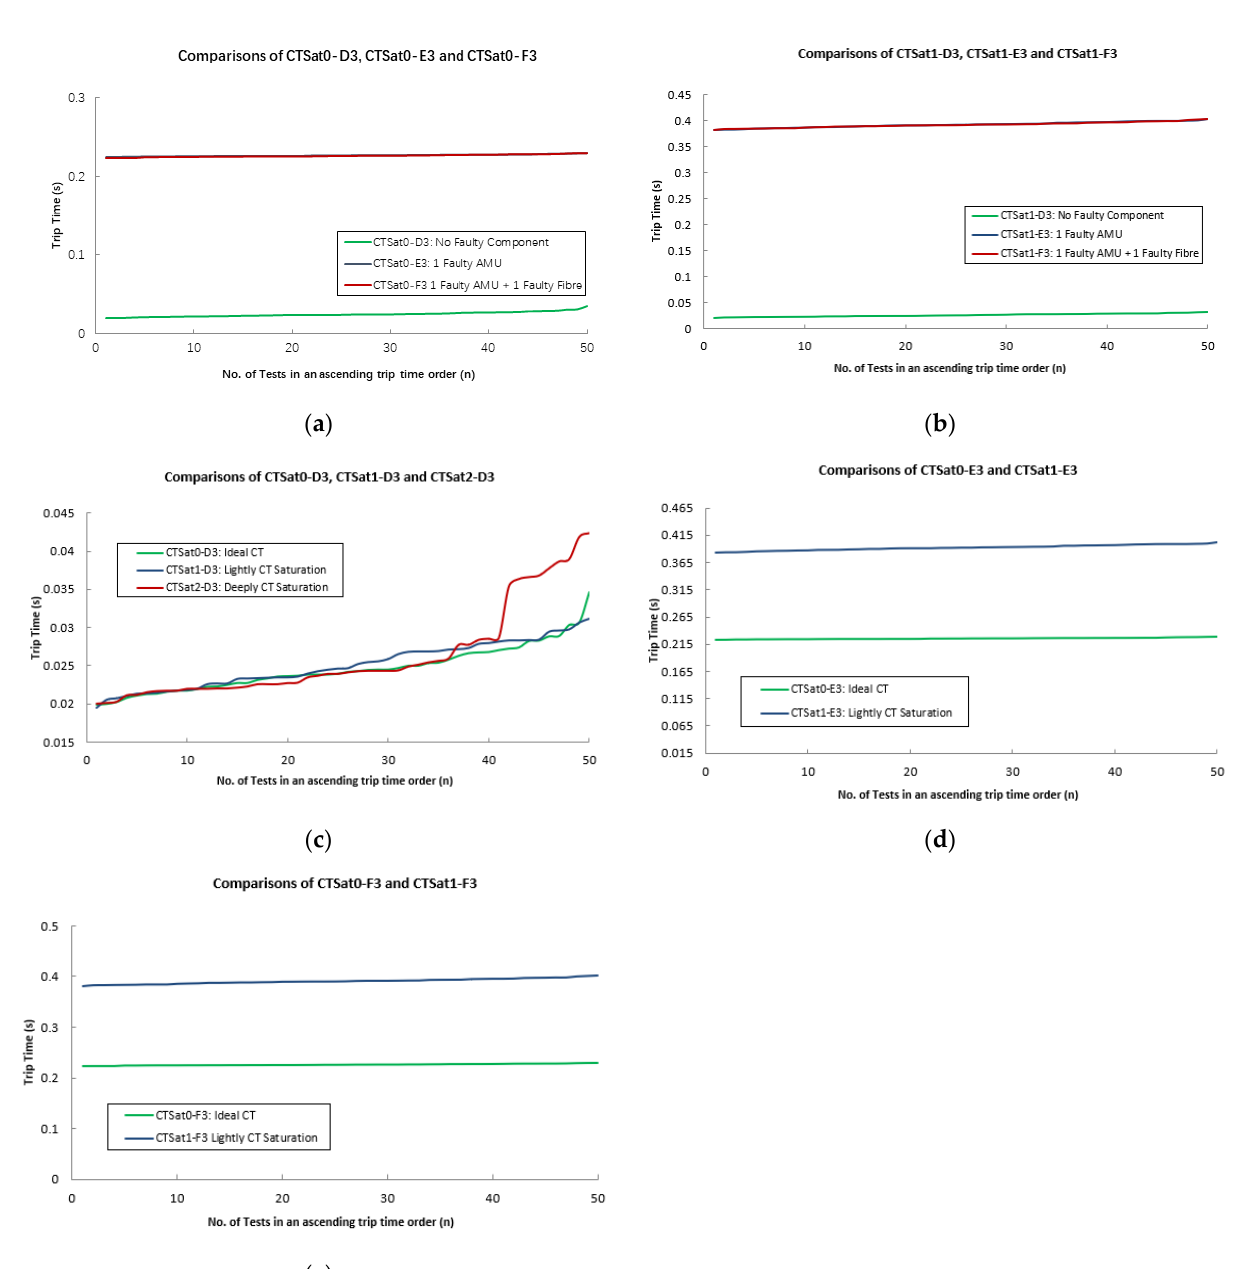
Figure 33. Comparisons: ( a ) CTSat0-D3, CTSat0-E3 and CTSat0-F3 (ideal CT, L-L-G fault at 100% of the feeder); ( b ) CTSat1-D3, CTSat1-E3 and CTSat1-F3 (light CT saturation, L-L-G fault at 100% of the feeder); ( c ) CTSat0-D3, CTSat1-D3 and CTSat2-D3 (no faulty component, L-L-G fault at 100% of the feeder); ( d ) CTSat0-E3 and CTSat1-E3 (1 faulty AMU, L-L-G fault at 100% of the feeder); and ( e ) CTSat0-F3 and CTSat1-F3 (1 faulty AMU + 1 faulty fibre, L-L-G fault at 100% of the feeder).